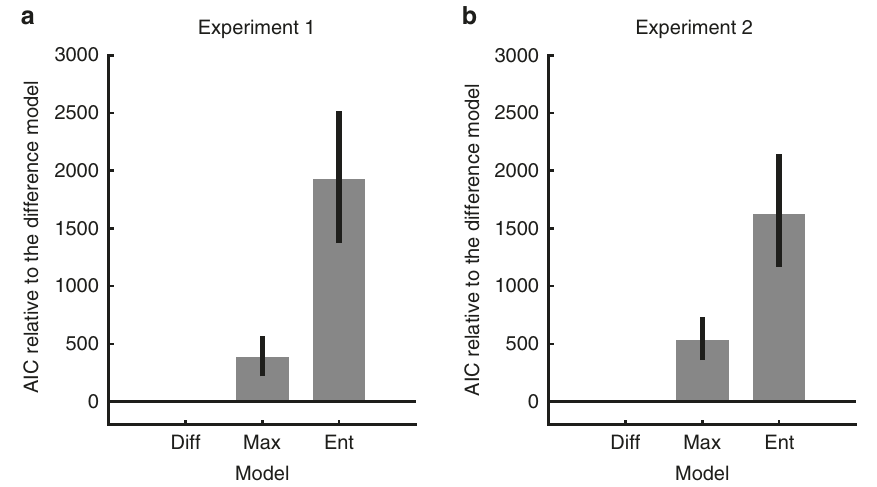
Fig. 4 Model comparisons using Δ AIC: AIC of each model compared with the Difference model. The bars represent Δ AIC summed across participants. The error bars represent 95% bootstrapped con fi dence interval. a Experiment 1. b